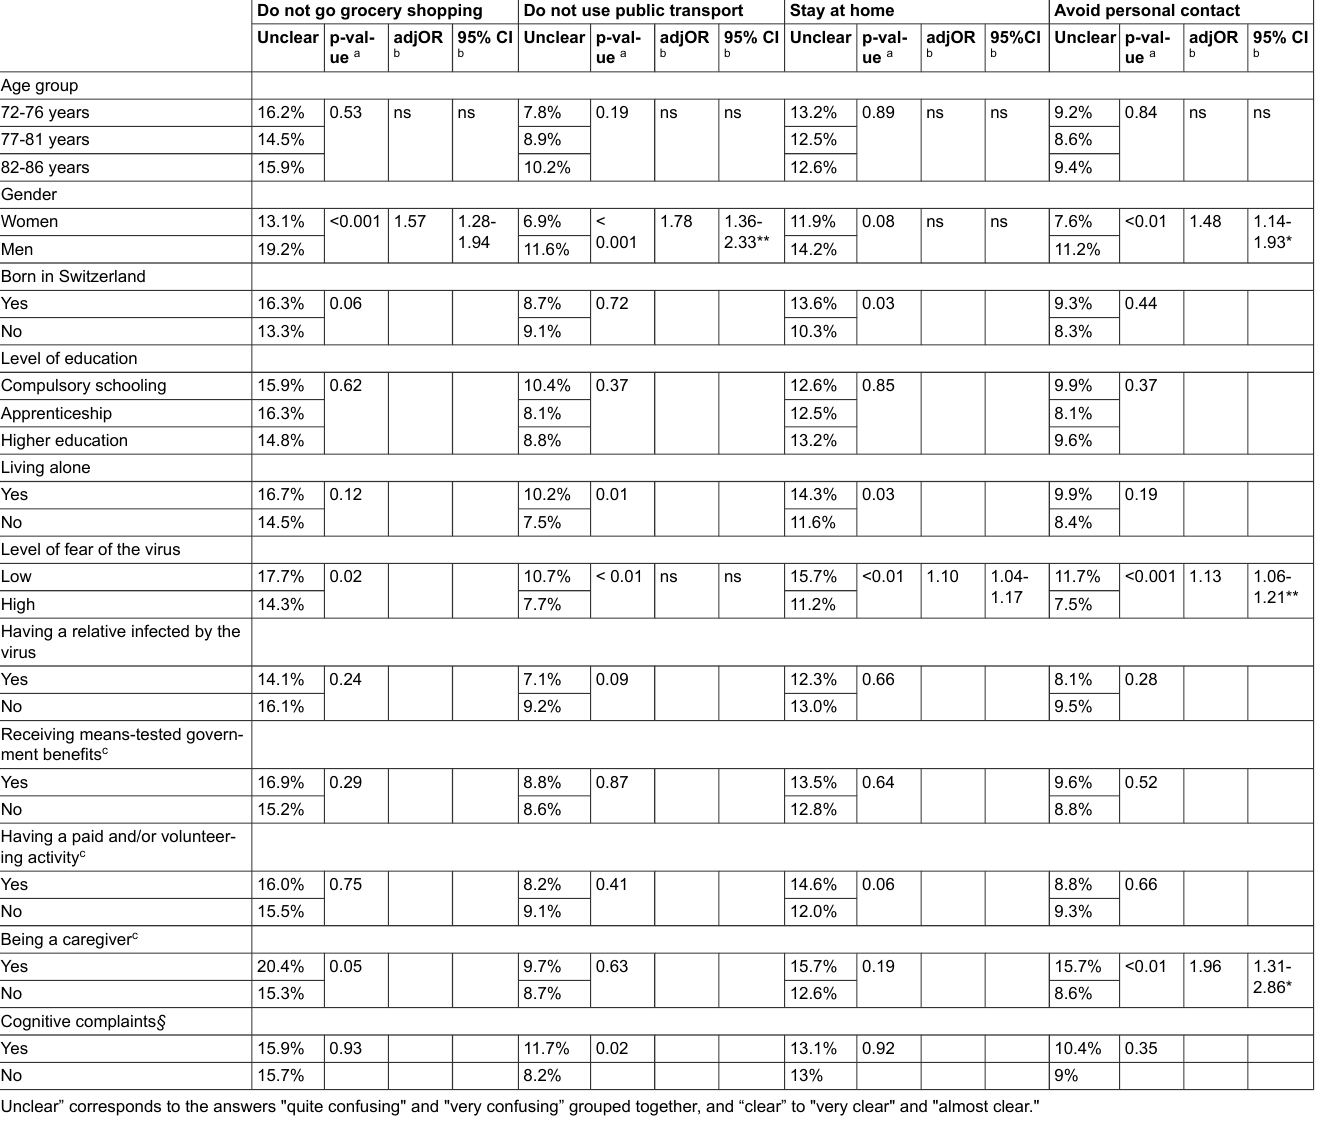
Table 4: Results from bivariable and multivariable analyses examining factors associated with rating the recommendations as unclear. Do not go grocery